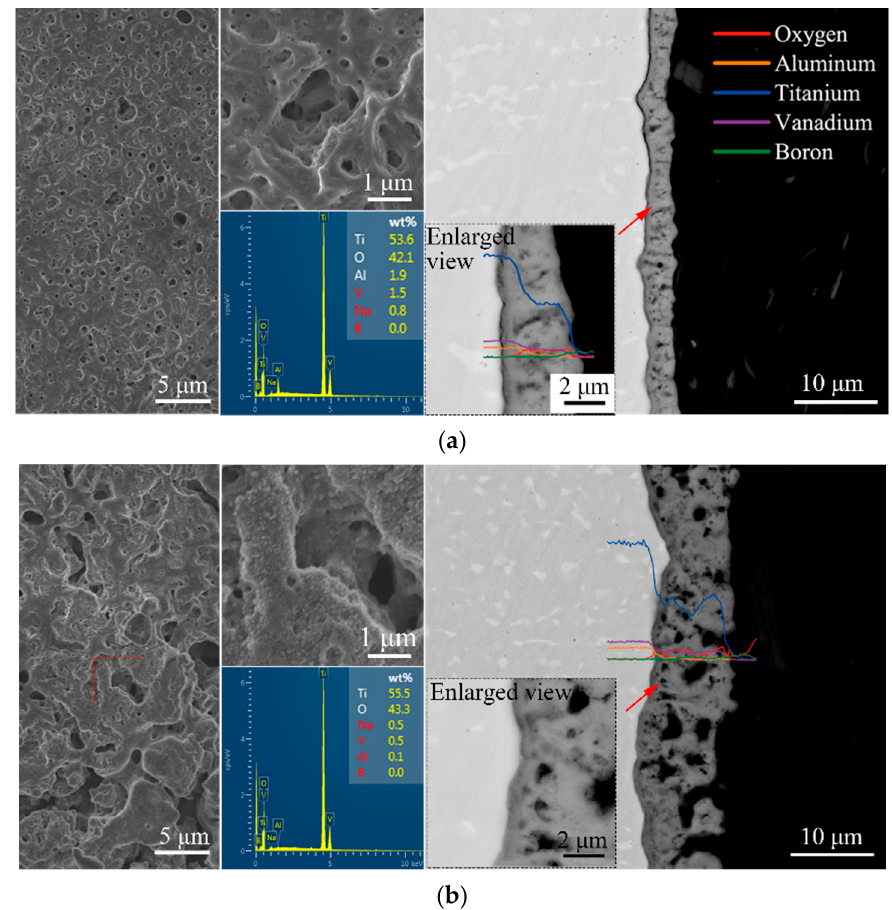
Figure 3. Surface morphology, cross-sectional morphology, and the corresponding EDS element distribution of the coating obtained by performing the MAO treatment in the Na 2 B 4 O 7 electrolyte for ( a ) 1000 and ( b ) 12,000 s.